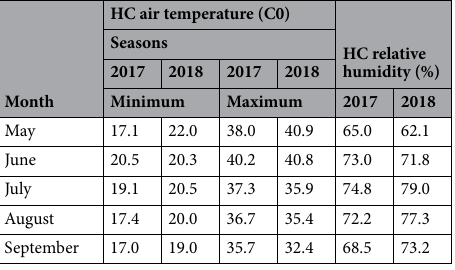
Table 1. Meteorological of the experimental site in both seasons. Source : Central Laboratory for Agriculture Climate, the Agriculture Research Center, Egypt.